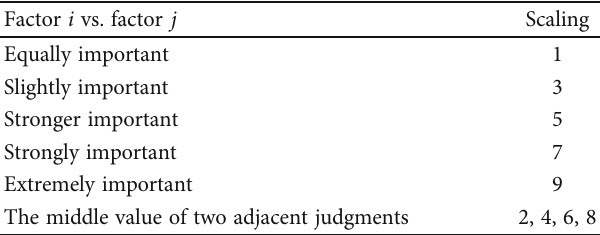
Table 3: Original NR assessment score.